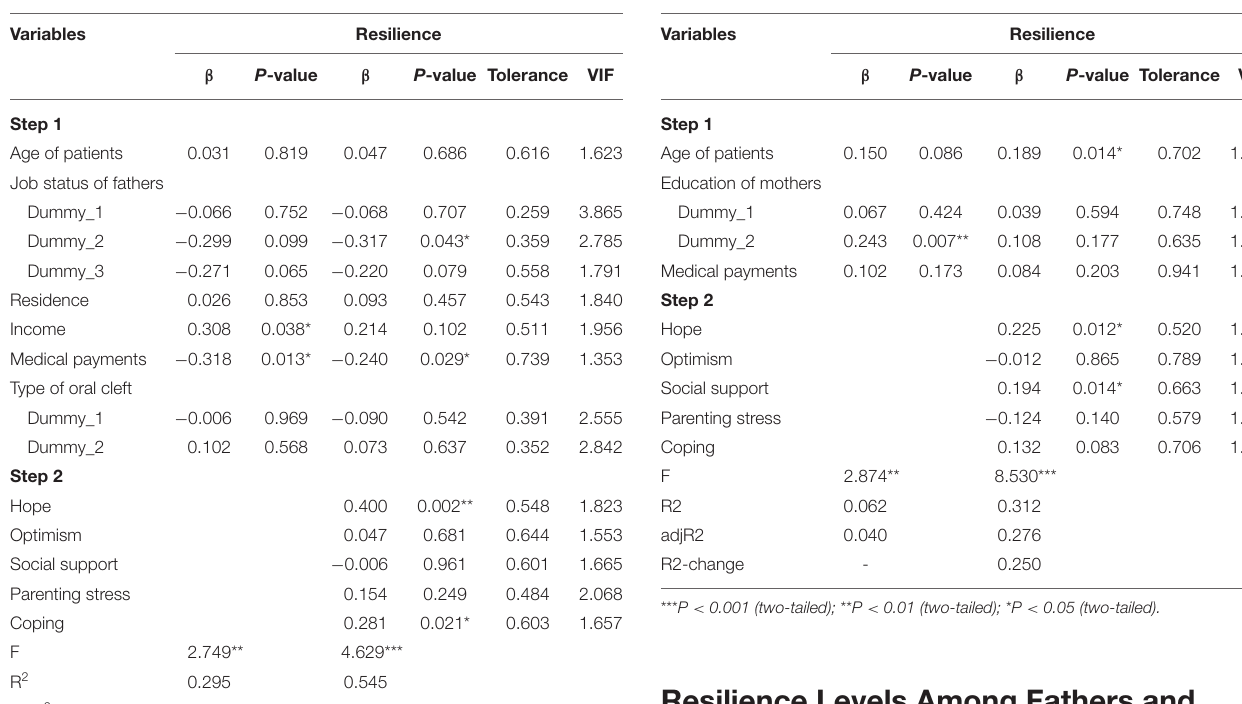
TABLE 6 | Hierarchical linear regression analysis on results of resilience among mothers of patients with CL/P ( n =